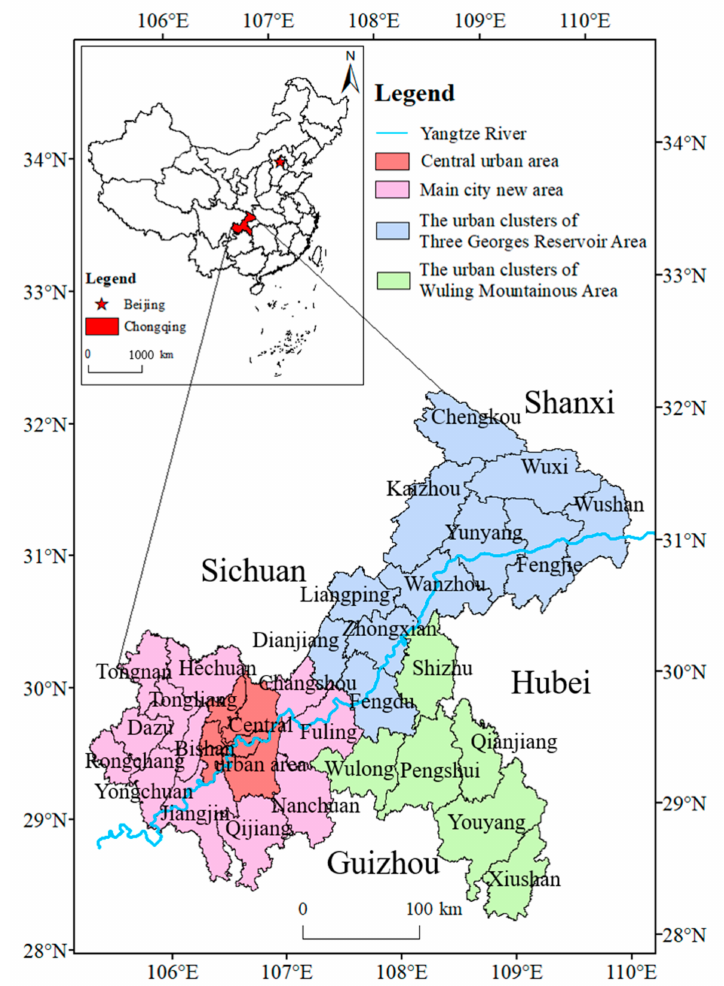
Figure 1. Location of Chongqing, China. Note: Based on the standard map (scale: 1:48 million) with the approval number of GS (2019) 1823 on the standard map service website, the base map was not